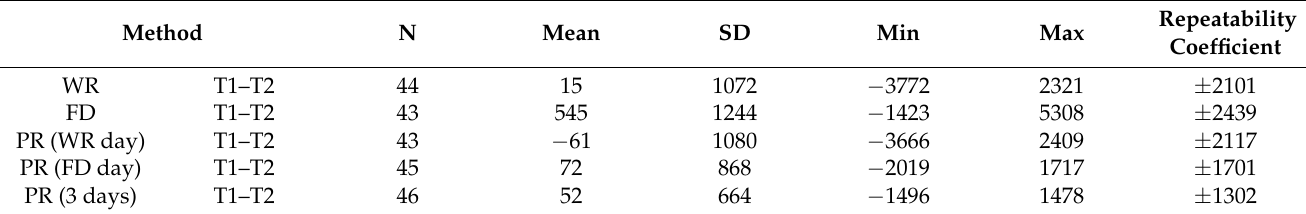
Table 6. Repeatability coefficient data for between assessment points difference in energy intake